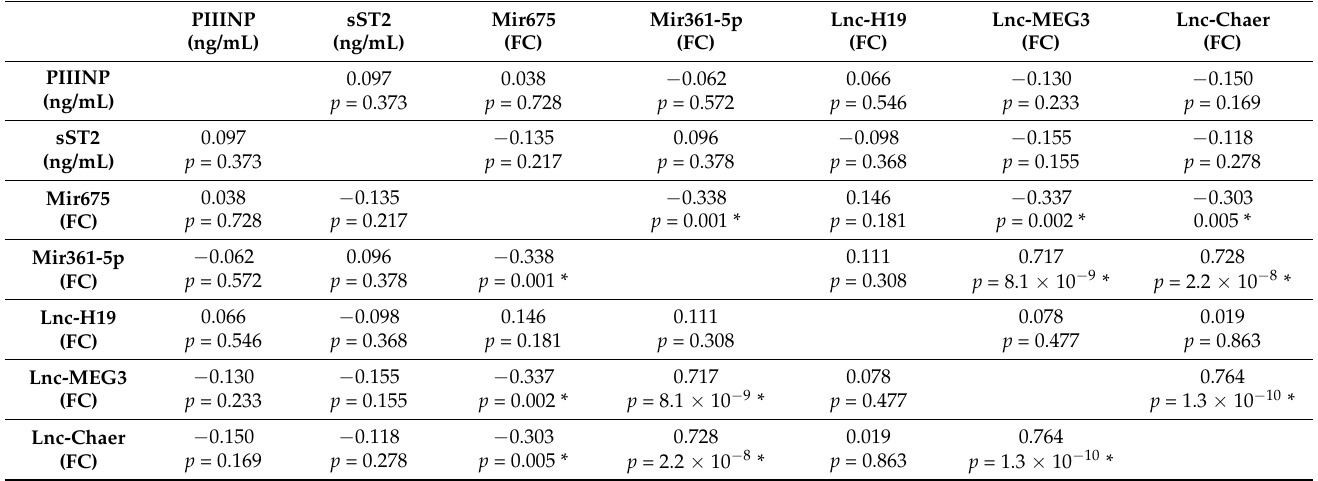
Table 9. Correlation between cardiac biomarkers and non-coding RNA among Heart failure